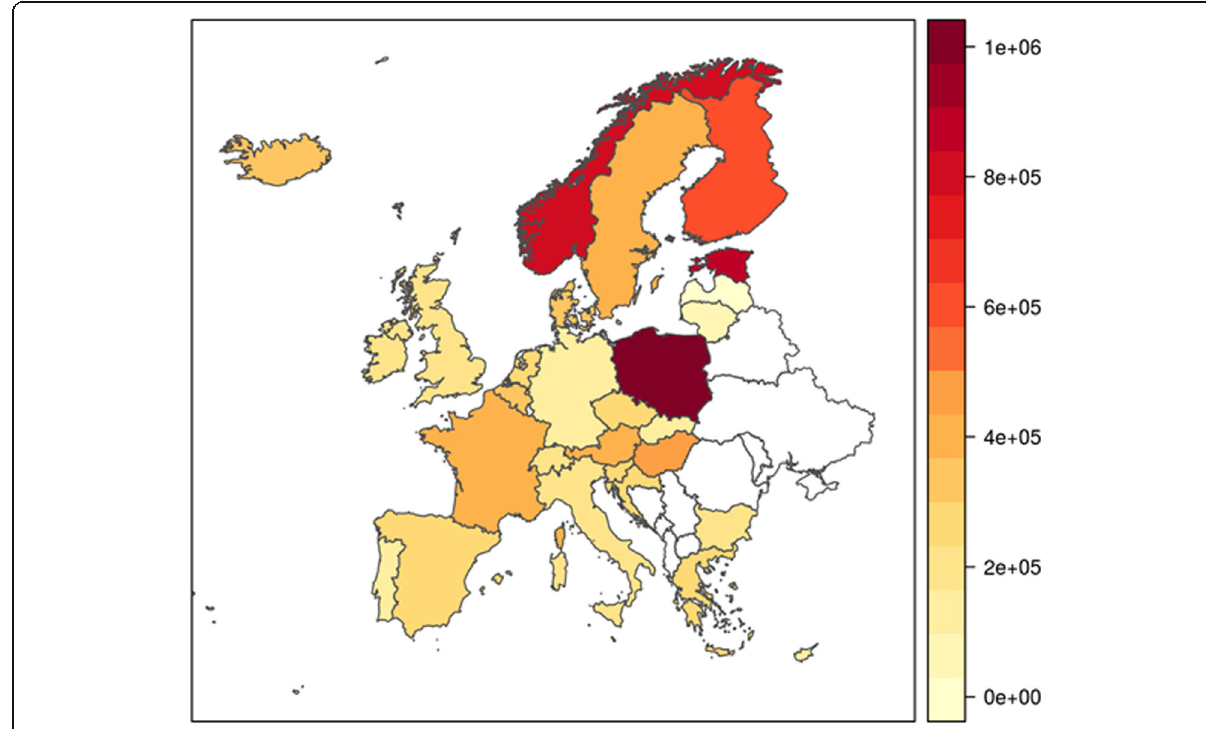
Fig. 1 Unit cost per serious injury (EUR 2015, adjusted for